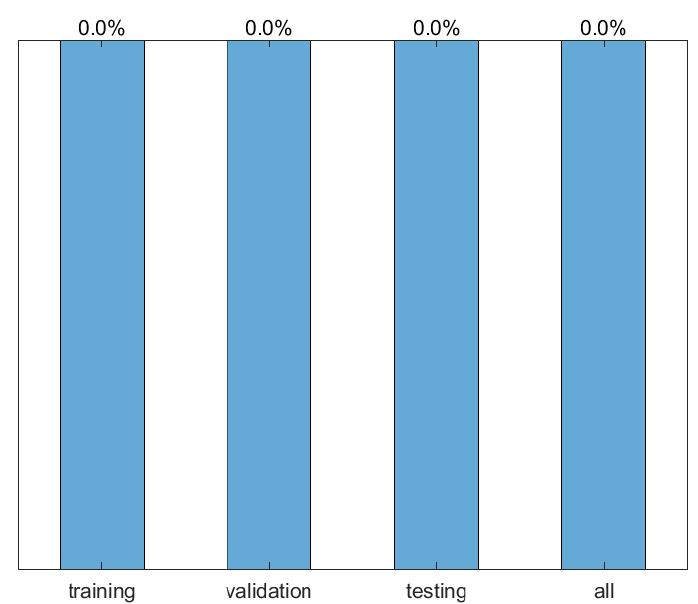
Fibers 2019 , 7 , x FOR PEER REVIEW Figure 6. Mean error of the di ff erent considered datasets. Figure 6. Mean error of the different considered datasets.